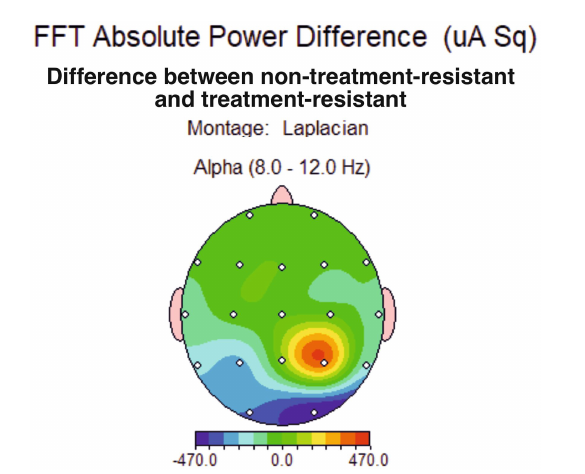
FIGURE 3 Topographical distribution of conventional alpha band average power difference between major depression group non-treatment- resistant (non-TRD) and treatment-resistant depression group (TRD), showing a slight power difference for the alpha band at P4